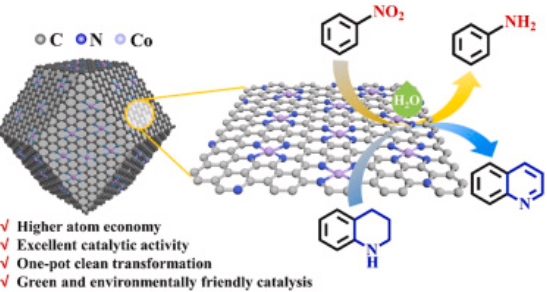
Figure 6. Transfer hydrogenation reaction of nitroarenes with saturated N-heterocycles by Co-N-C- 900 catalyst. Reprinted with permission from Ref. [32]. Copyright © Elsevier B.V. 2021.